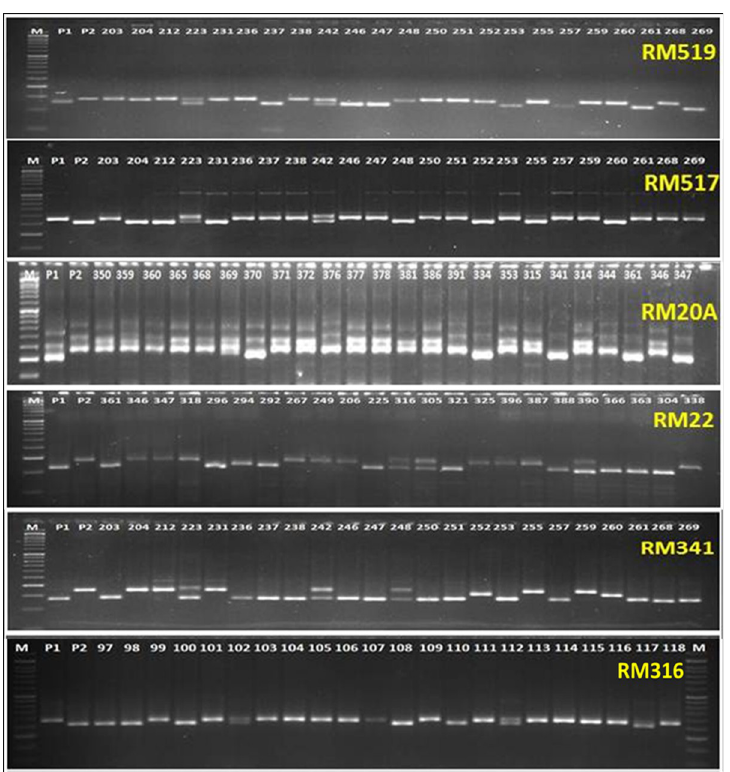
Fig 2. Electrophoregram showing polymorphism pattern of SSR primers with different recombinant lines. The numbers represent the different RI line numbers used in mapping. Respective primer names are given in the right top corner position in each gel photos. P1: Tolerant parent; P2: Susceptible parent, M: 50bp DNA ladder.